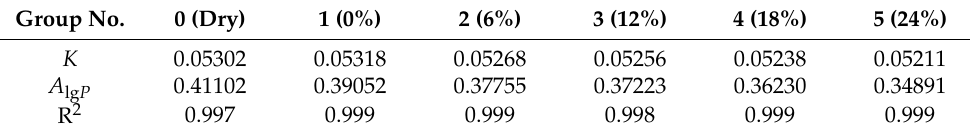
Figure 3. The variation of high-temperature performance with different chloride salt concentrations: ( a ) Softening point; ( b ) Equivalent softening point. Table 2. Fitting parameters of penetration–temperature linear